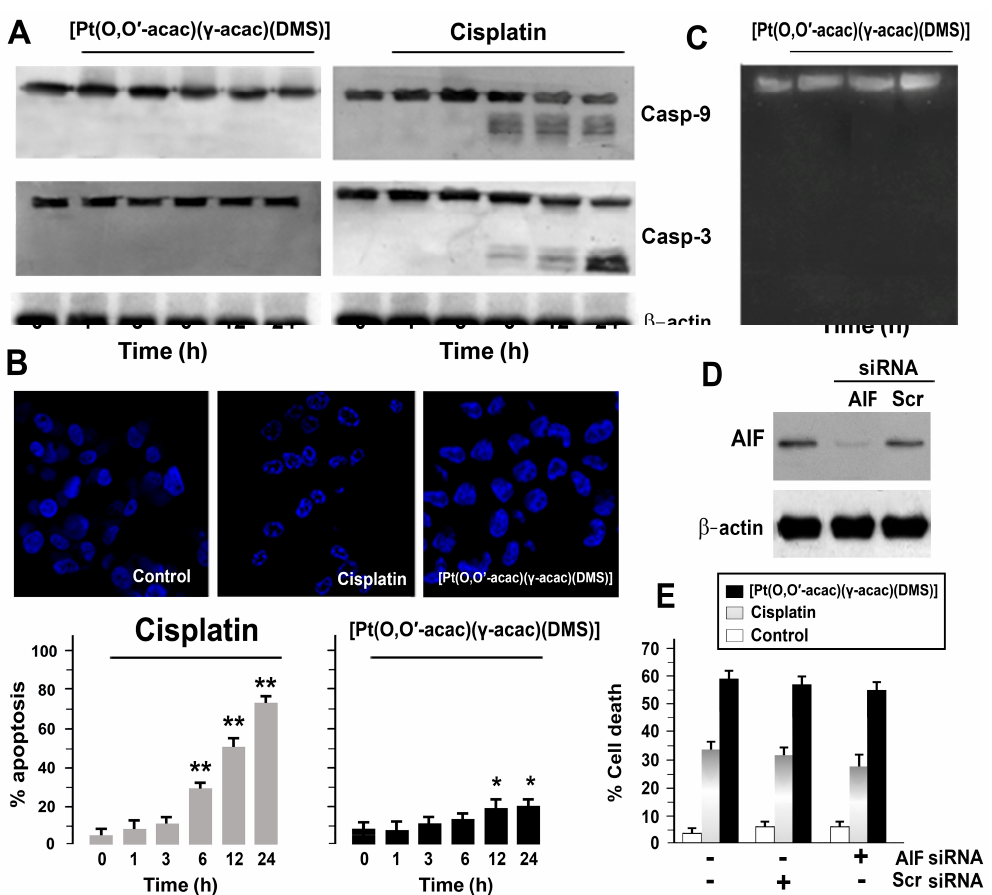
Figure 2. [Pt( O,O’ -acac)( γ -acac)(DMS)] does not induce apoptosis in Caki-1 cells. ( A ) Expression of cleaved caspase-9 and -3 in Caki-1 cells. Cell were treated with 10 µM of [Pt( O,O’ -acac)( γ -acac)(DMS)] or 50 µM of cisplatin for the indicated time, and then subjected to Western blotting. Incubation with anti- β -actin confirmed the equal protein loading. The results shown are representative of three different experiments. ( B ) (Up) Caki-1 cells were treated, or not, with cisplatin, or with [Pt( O,O’ -acac)( γ -acac)(DMS)] for 24 h, and then stained with 4,6-diammine-2-phenylindol (DAPI); the representative fields by confocal microscopy (magnification 40×) of one of four independent experiments are shown. (Down) Quantification of the percentage of apoptotic nuclei obtained from cells stained with DAPI (means ± SD; n = 4), after treatment for different times with 10 µM [Pt( O,O’ -acac)( γ -acac)(DMS)] or 50 µM cisplatin. ** p < 0.01 between cisplatin-treated and untreated cells and * p < 0.05 between [Pt( O,O’ -acac)( γ -acac)(DMS)]-treated and untreated cells, by Student’s t -test. ( C ) Visualization of DNA fragmentation in [Pt( O,O’ -acac)( γ -acac)(DMS)]-treated Caki-1 cells. Total DNA was isolated and separated on a 1% agarose gel. A representative example of three independent experiments is shown. ( D , E ) Caki-1 cells were transfected with 30 nM small interfering RNA (siRNA) oligos for apoptosis inducing factor (AIF) and then treated with 10 µM [Pt( O,O’ -acac)( γ -acac)(DMS)]. ( D ) Immunoblotting detection of AIF in cell extracts 48 h after siRNA transfection using polyclonal anti-AIF antibody. Controls were provided by untransfected cells and cells transfected with scrambled siRNA oligos (Scr). Incubation with anti- β -actin confirmed the equal protein loading. A representative example of three independent experiments is shown. ( E ) Cell death was quantified by FACS after propidium iodide (PI)/annexin V-FITC staining, in transfected Caki-1 cells treated with 10 µM of [Pt( O,O’ -acac)( γ -acac)(DMS)] or 50 µM cispltin for 24 h. Data are means ± SD of five independent experiments.